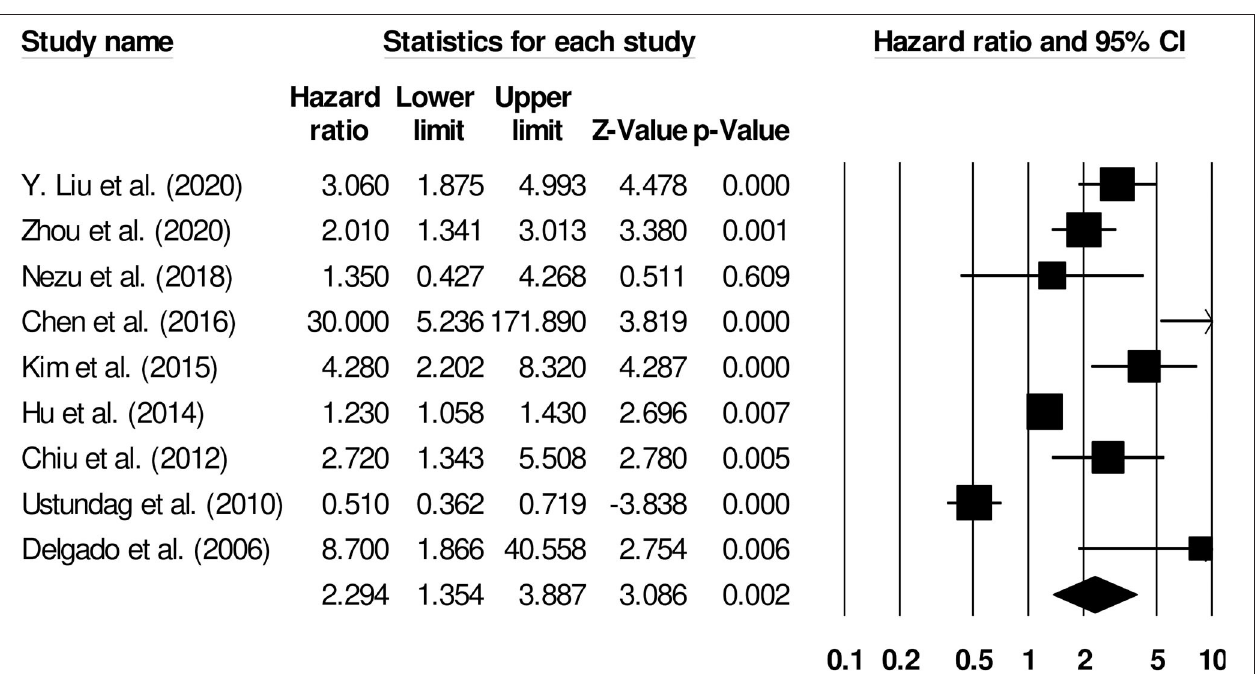
FIGURE 9 | Forest plot for studies evaluating the impact of D-dimer level on post-stroke mortality outcomes. Hazard ratios are presented as black boxes while 95% confidence intervals are presented as whiskers. A small hazard ratio represents a lower influence of D-dimer levels on stroke patient functional outcome while a higher hazard ratio represents a higher